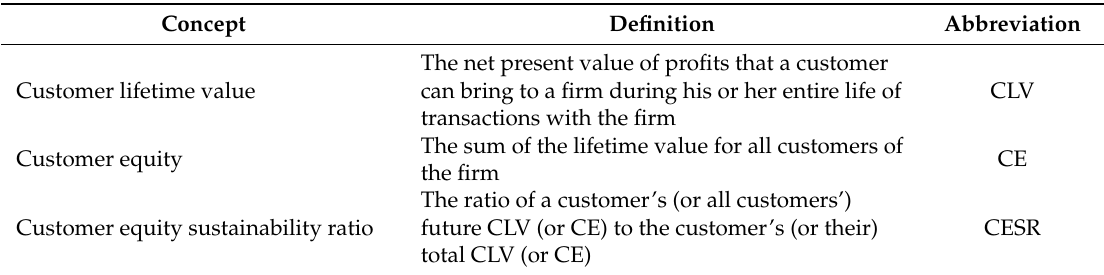
Table A1. List of major concepts and